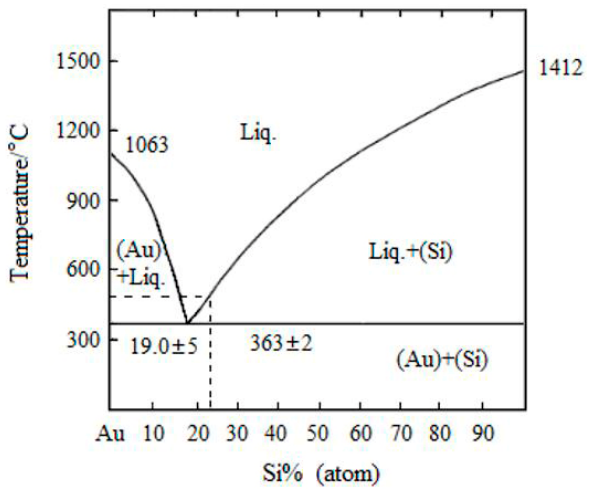
Figure 4. Au–Si phase diagram [24]. Legend: Liq., liquid.